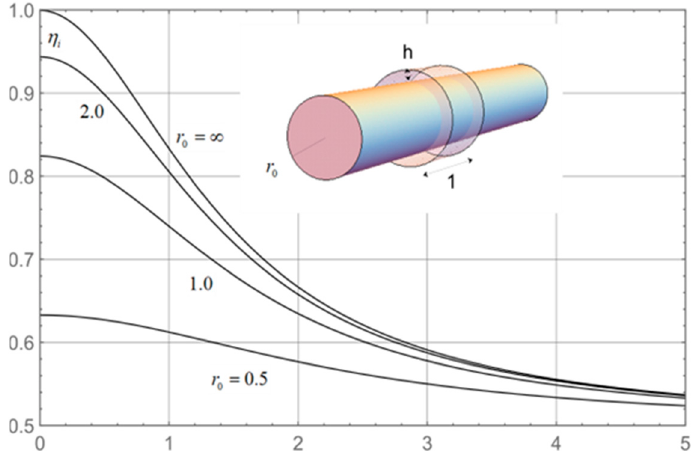
Figure 19. Efficiency of a thrust-generating ring-wing, heaving with respect to a circular cylinder in extreme ground effect for different ratios of the cylinder radius to the chord.